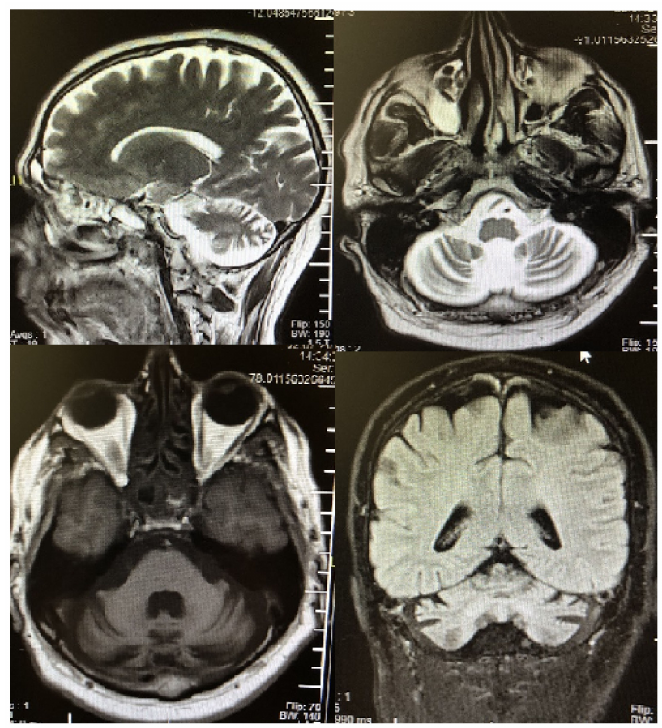
Figure 1. Brain MRI revealed a significant cerebellar atrophy in the